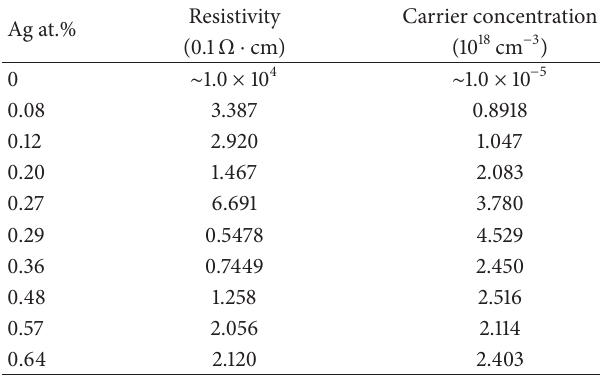
Table 3: Electrical properties of the In dopant levels. Ag